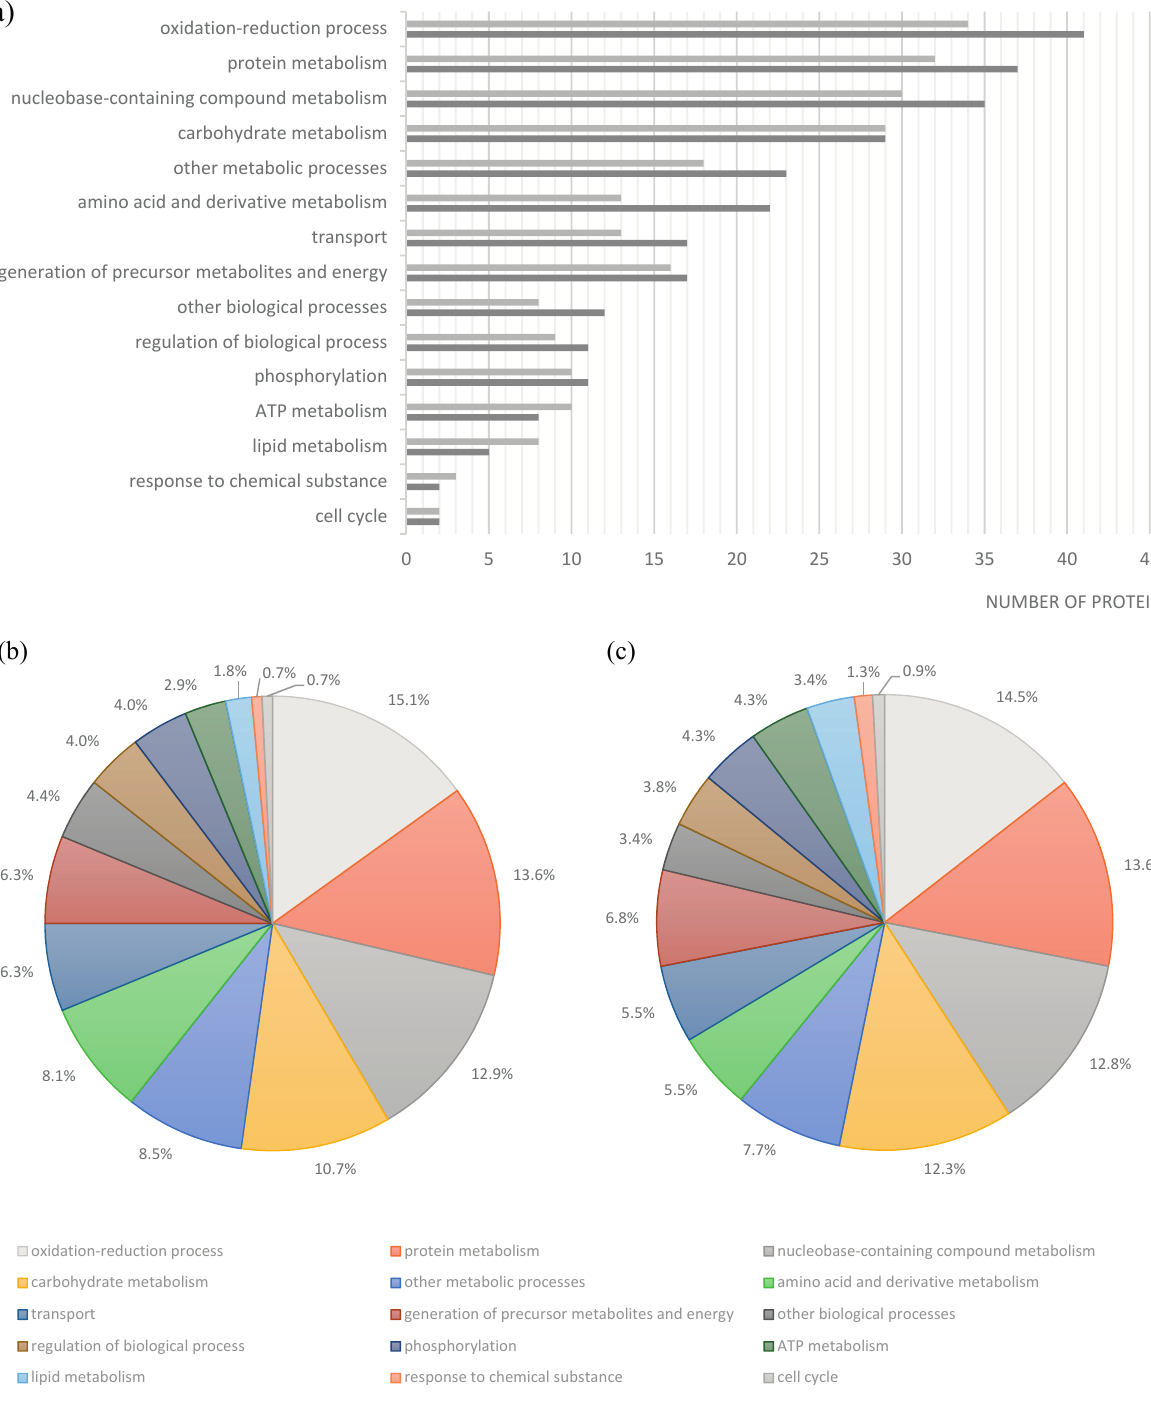
Figure 3. Functional classification of proteins identified in the Se20 and SL1344 strains based on Gene Ontology. ( a ) Number of proteins in each category for Se20 (light gray) and SL1344 (dark gray); Relative percentages of protein functions in ( b ) Se20 and ( c ) SL1344. As this classification reflects the fact that single proteins can be involved in more than one process, the sum of proteins in all categories is higher than the total number of unique proteins